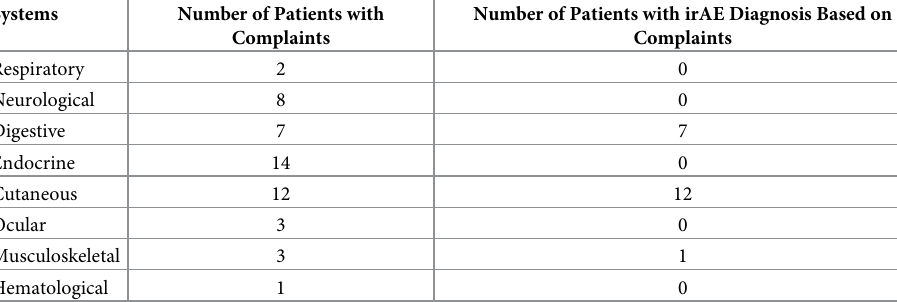
Table 5. Association between complaints and immune-related adverse